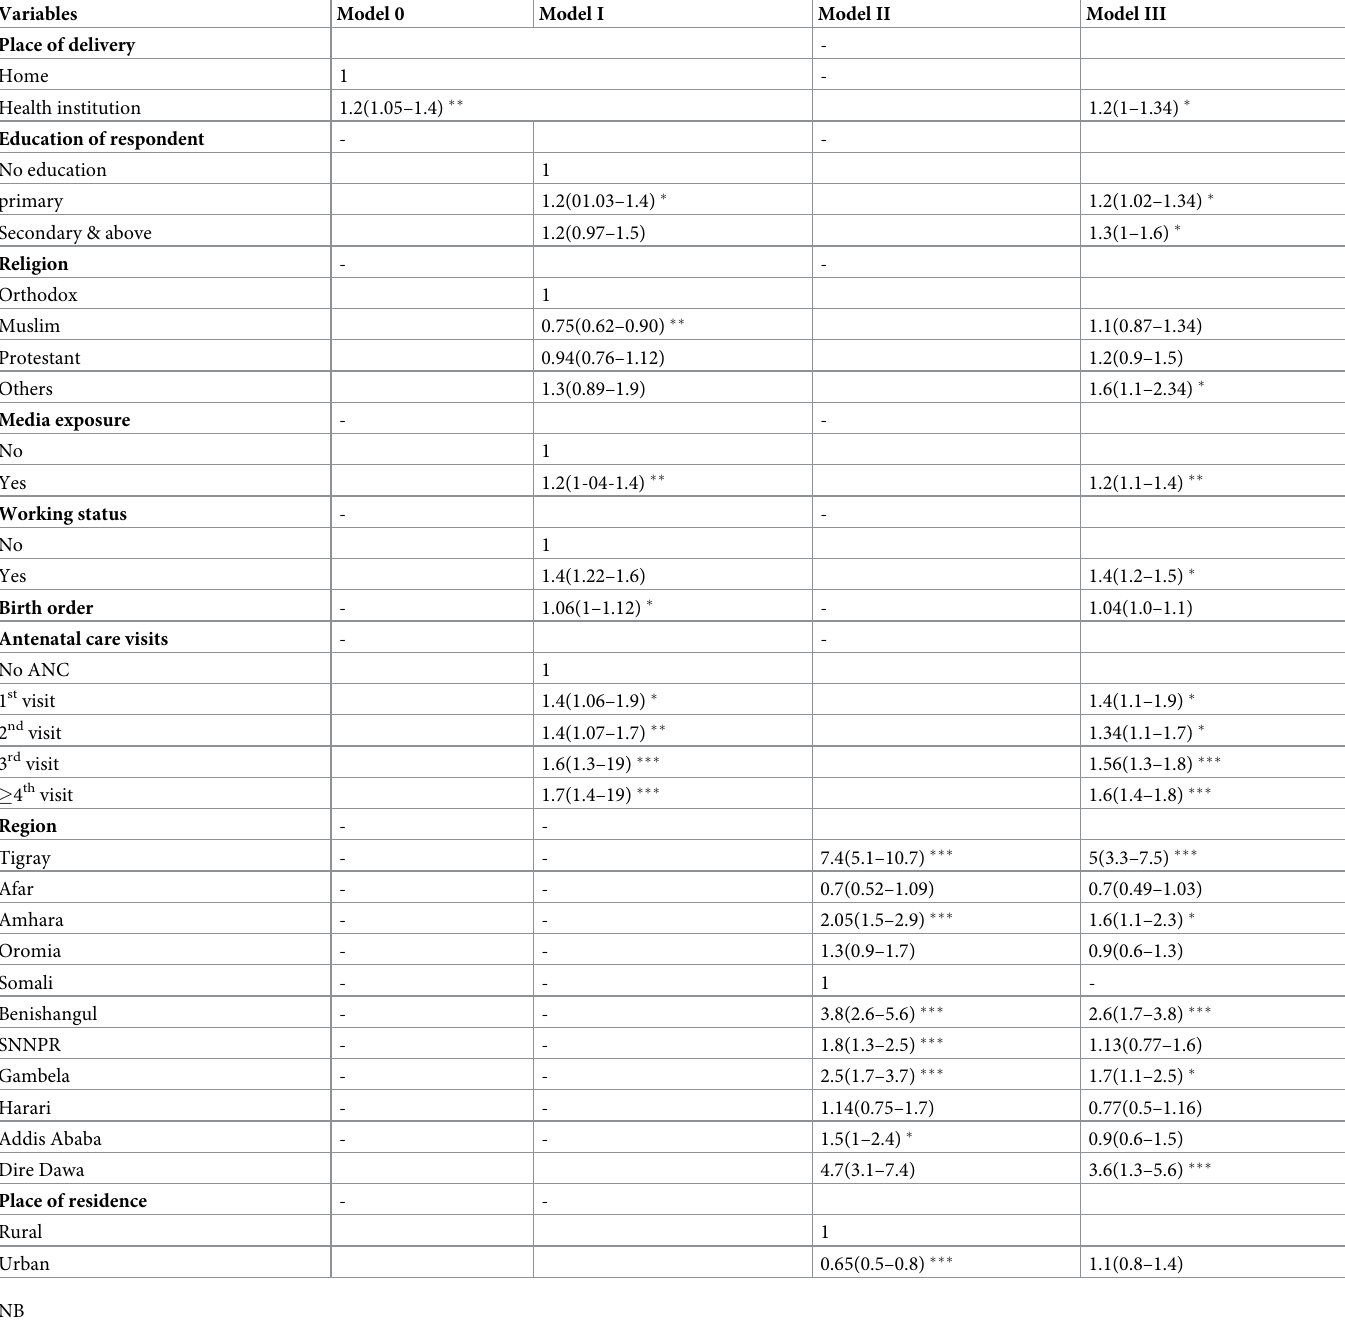
Table 3. Multilevel logistic regression on vitamin A supplementation among children aged 6–59 months in Ethiopia,